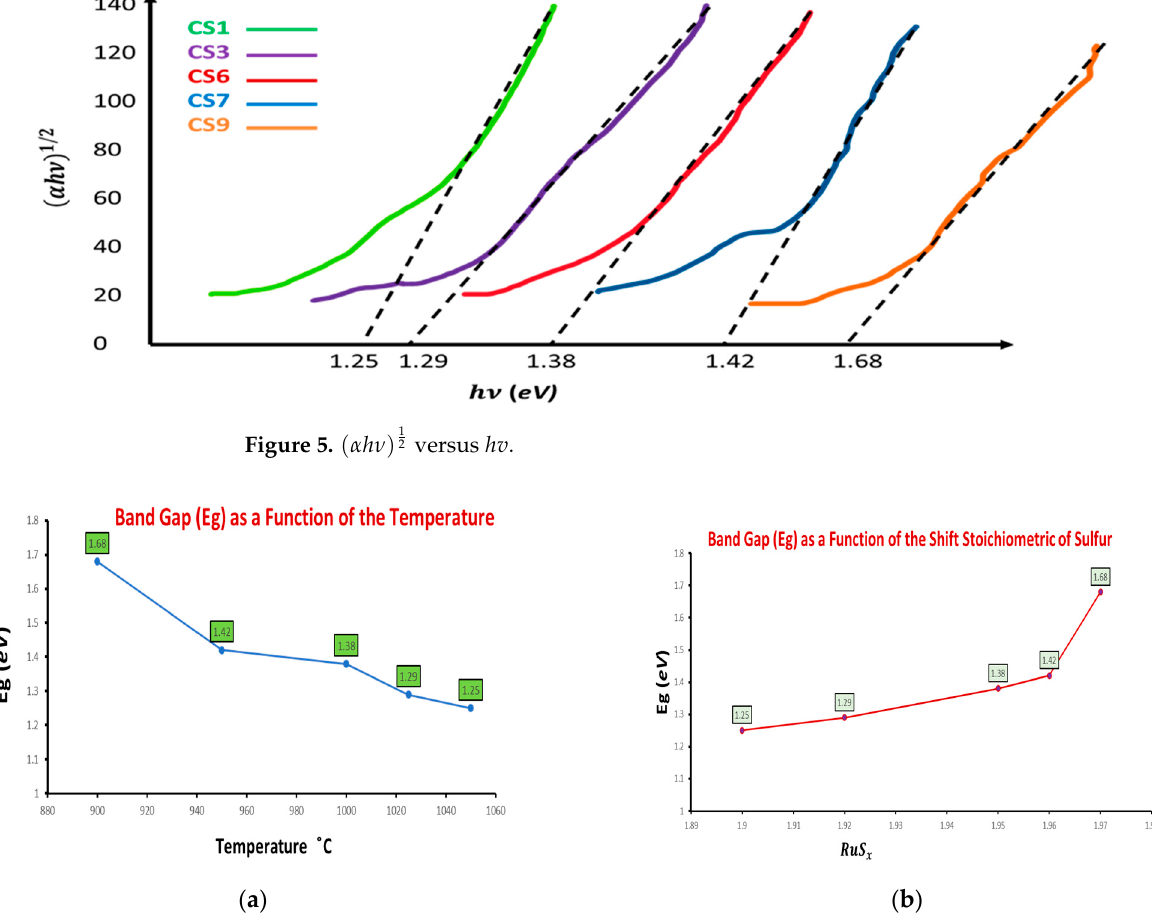
Figure 6. ( a ) Band gap versus temperature, ( b ) band gap versus stoichiometric shift of Sulfur. Table 5. Exprimental crystals